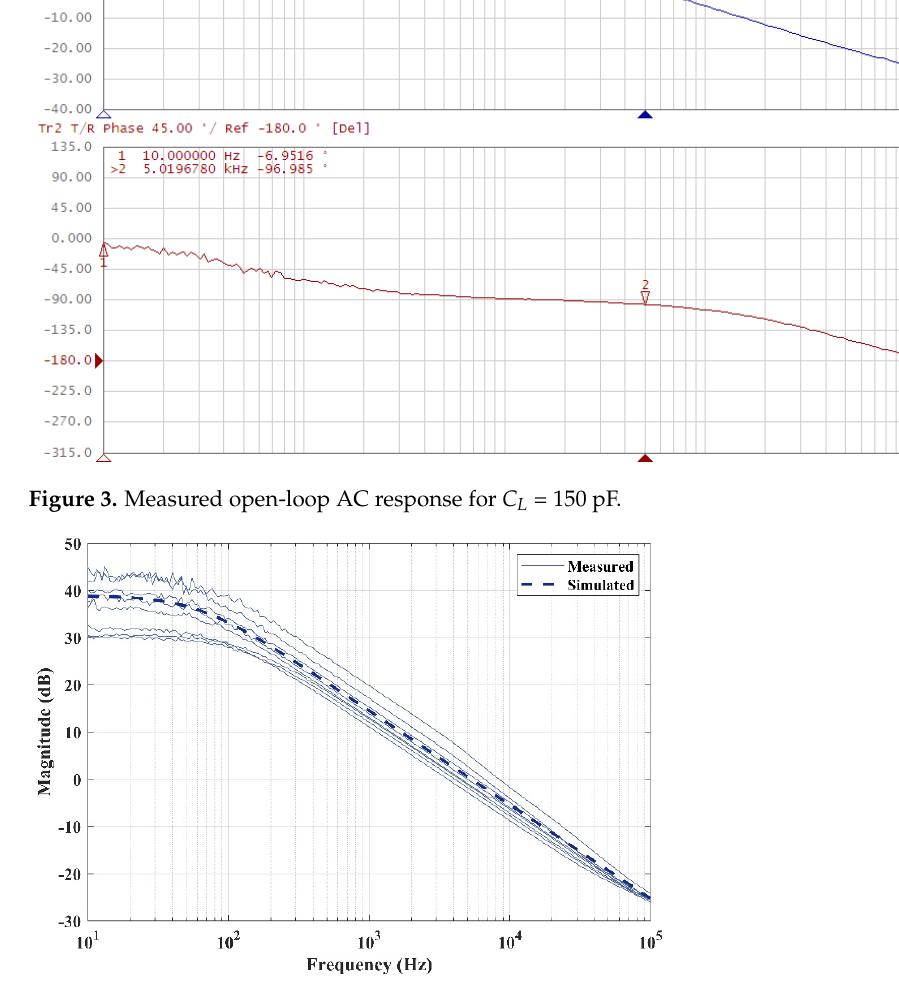
Figure 4. Measured open-loop gain for all the samples superimposed to simulations for C L = 150 pF. Table 2. Average main performance parameters over 10 samples for C L = 150